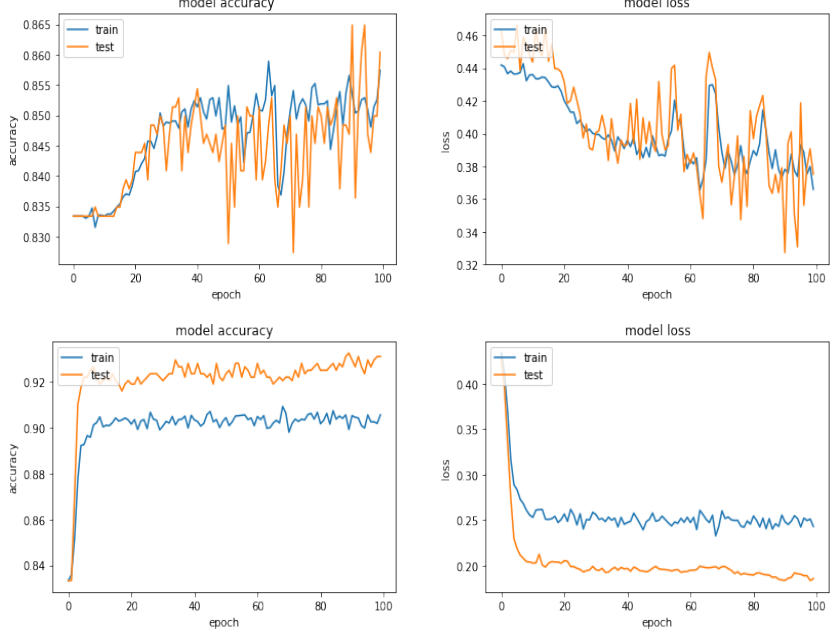
Figure 19. Accuracy and Loss for LSTM and VAE-CNN for six-class classification for training and validation phase,